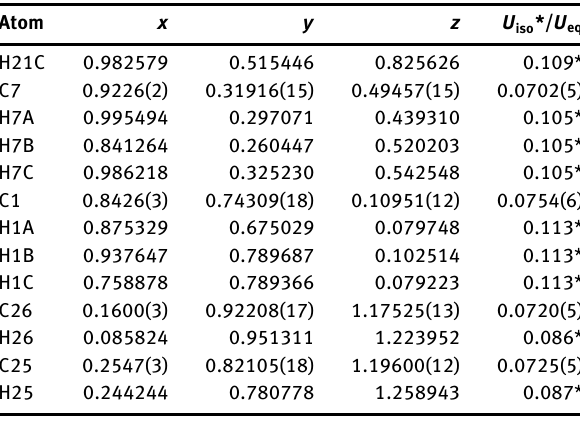
Table 2: Fractional atomic coordinates and isotropic or equivalent isotropic displacement parameters (Å 2